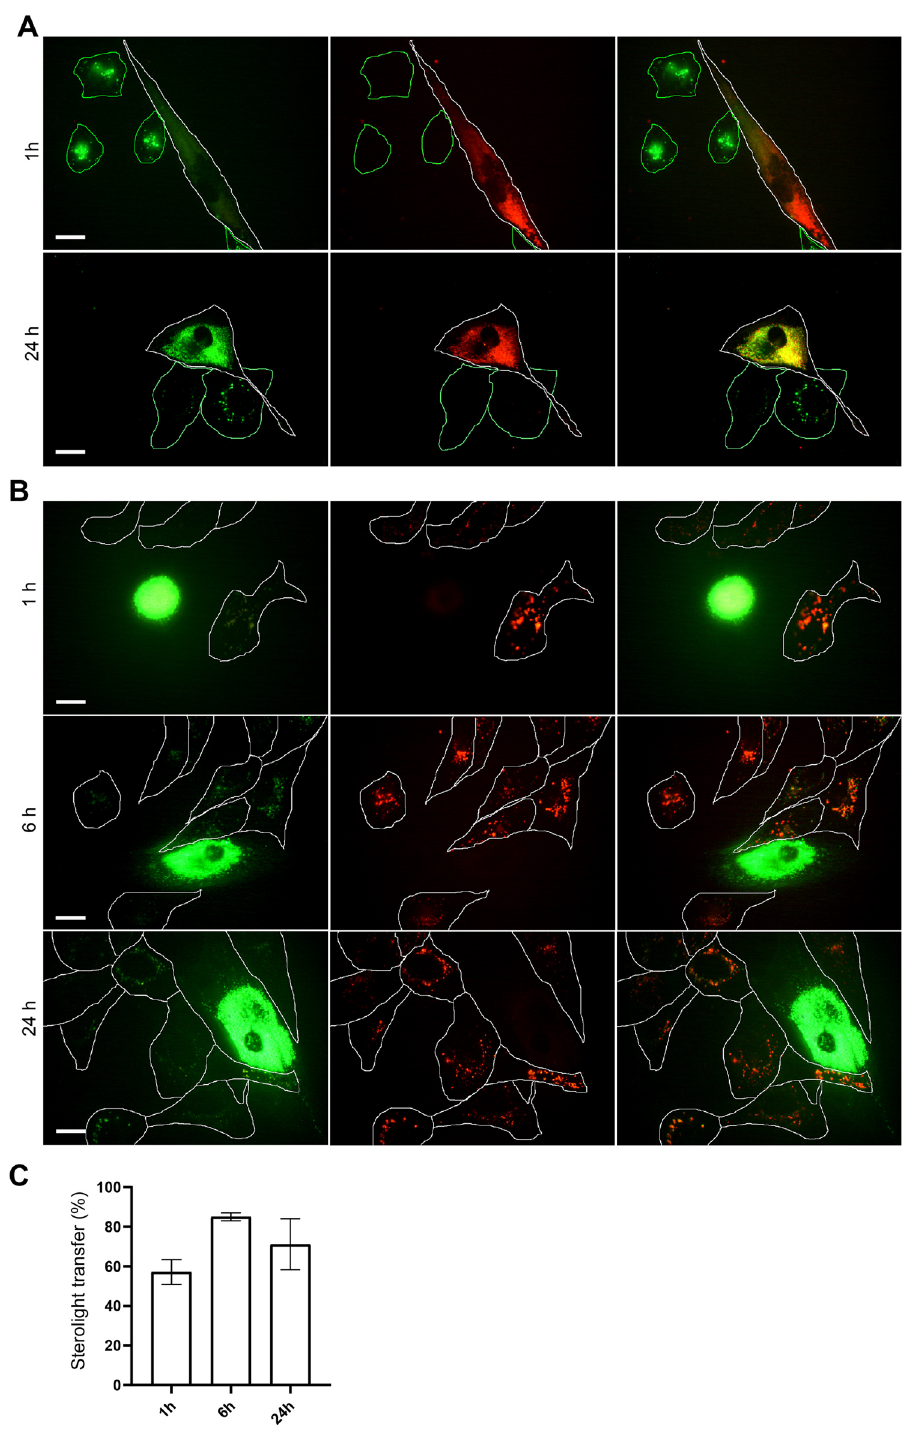
Figure 7. Sterolight transfer between U-2 OS and NPC1 mutated cells. NPC1 cells (clone GM03123) were either labelled with RhoDex ( A ) or Sterolight probe via pulse ( B ) and co-cultivated with inversely labelled U-2 OS cells for 1 or 24 h. ( A ) Sterolight probe originating from U-2 OS cells (outlined green) was detected in 100% RhoDex-labelled NPC1cells (outlined white) within 1 h ( A , top row). After 24 h, Sterolight signal accumulated mainly in NPC1 cells ( A , bottom row). ( B ) NPC1 cells labelled with Sterolight probe were, after harvest, plated to RhoDex-labelled U-2 OS cells (outlined) and co-cultivated for 1, 6, and 24 h. Transfer of Sterolight form NPC1 cells to U-2 OS was detectable, but less pronounced (lower fluorescence was evident in 56–85 % of acceptor cells, depending on incubation time, panel C ). Scale bar 10